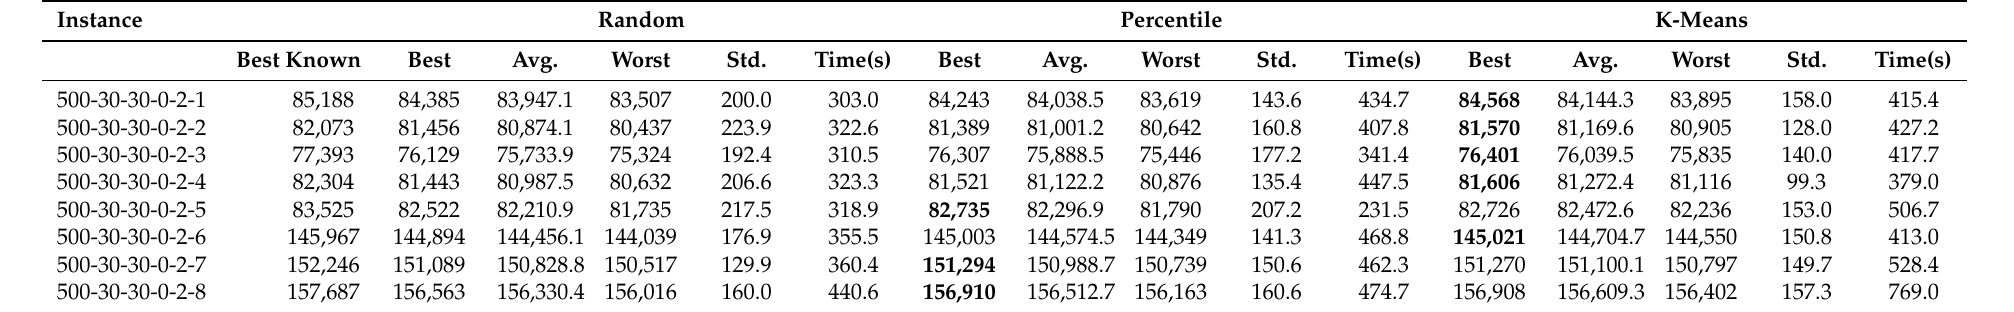
Table 5. Comparison between Random, Percentile and K-means binarization methods for 500-30-30 instances and cuckoo search